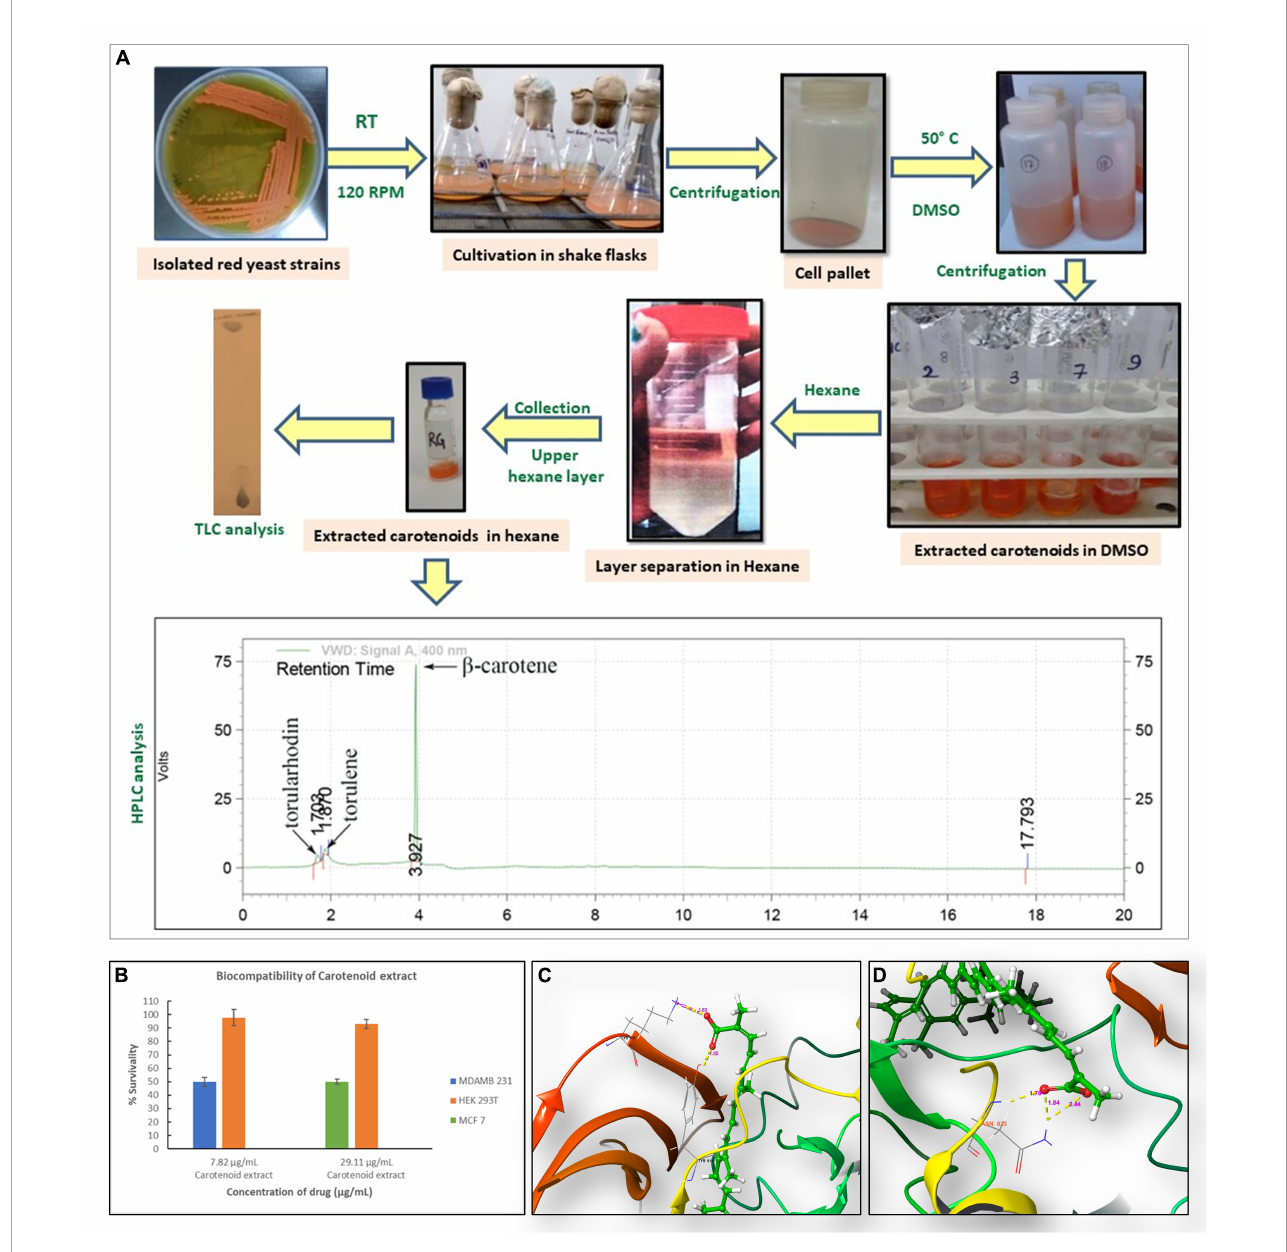
FIGURE1 (A) Flow diagram for extraction of yeast carotenoids and its analysis. (B) Survivability analysis of carotenoid extract in HEK 293T with respect to IC 50 concentrations of MCF7 (29.11 µ g/ml) and MDA-MB-231 (7.82 µ g/ml). HEK293T cells showed insignificant changes in proliferation. Results are representative of three independent experiments. (C) 3D interaction diagram between torularhodin and vascular endothelial growth factor receptor 1 (VEGFR1) showing hydrogen bond formed with asparagine 923 at the active site of the protein and carboxyl group moiety of torularhodin. (D) 3D interaction diagram between torularhodin and VEGFR2 showing hydrogen bond formed with lysine 831 and tyrosine 911 at the active site of protein and carboxyl group moiety of